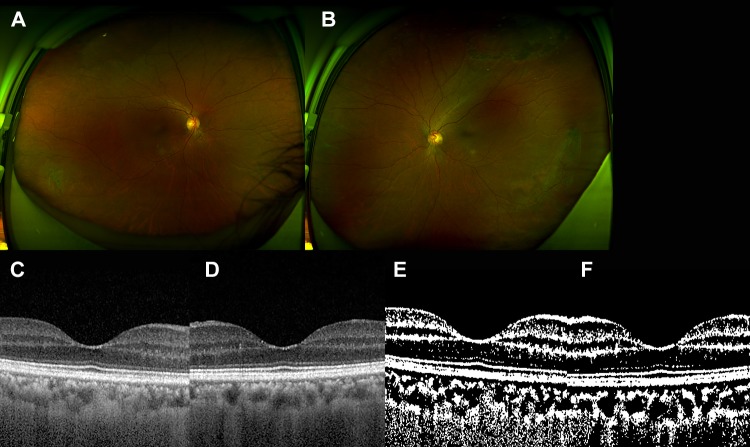
The 61-year-old female patient who underwent uncomplicated cataract surgery in both eyes.She had past history of hypertension. (A and B) There was no significant sign in the right eye (A) and lattice degeneration in the left eye (B). (C and D) There was no significant finding in each eye by spectral domain optical coherence tomography (C, right eye, and D, left eye). The mean subfoveal choroidal thickness was 207.5 μm in the right eye and 195.5 μm in the left eye. (E and F) After binarization, (E) the choroidal area was 516,100.0 μm2 and the luminal area was 322,600.0 μm2 in the right. (F) The choroidal area was 496,800.0 μm2 and the luminal area was 354,800.0 μm2 in the left eye.